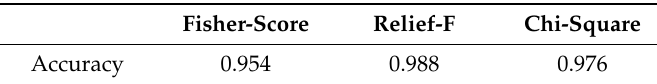
Table 8. Training set results of